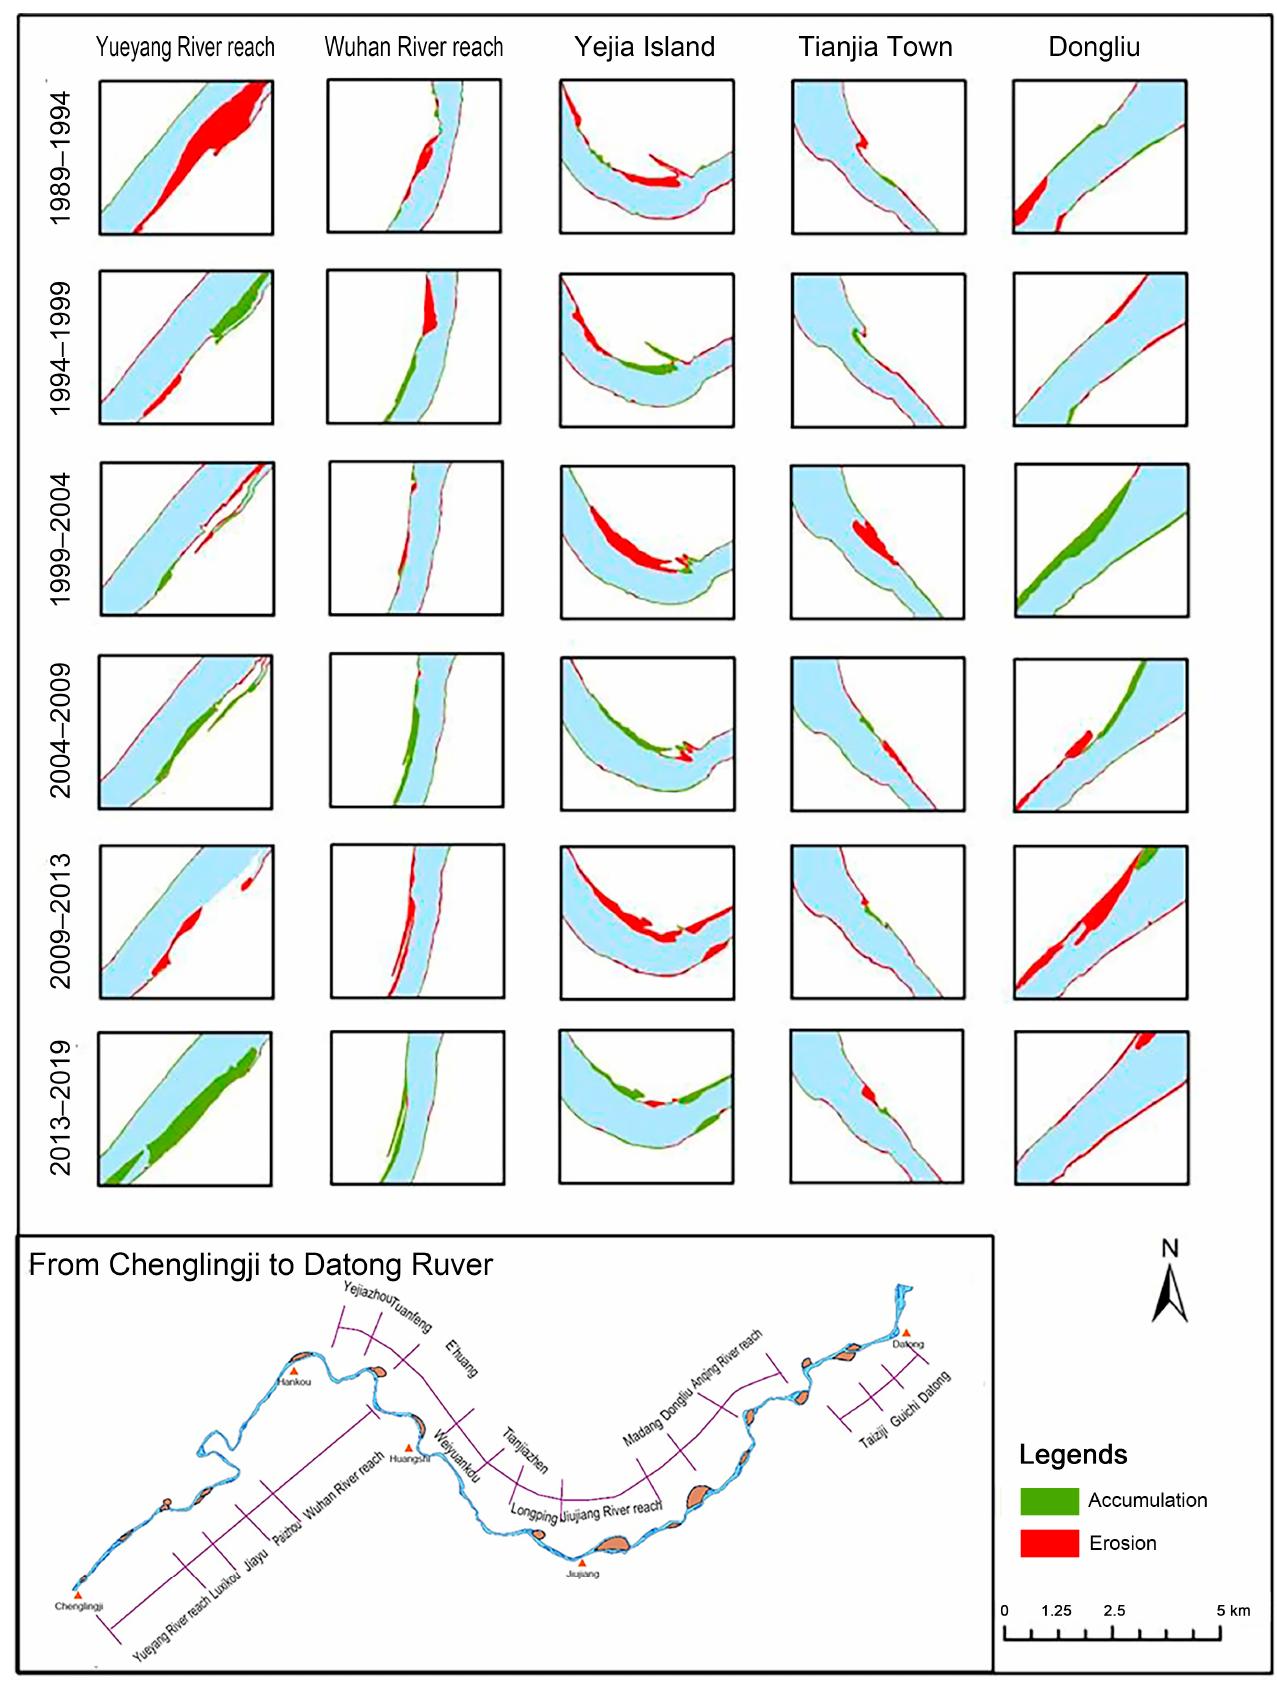
Figure 3. Changes of scouring and accumulation in di ff erent periods from Chenglingji to Datong.